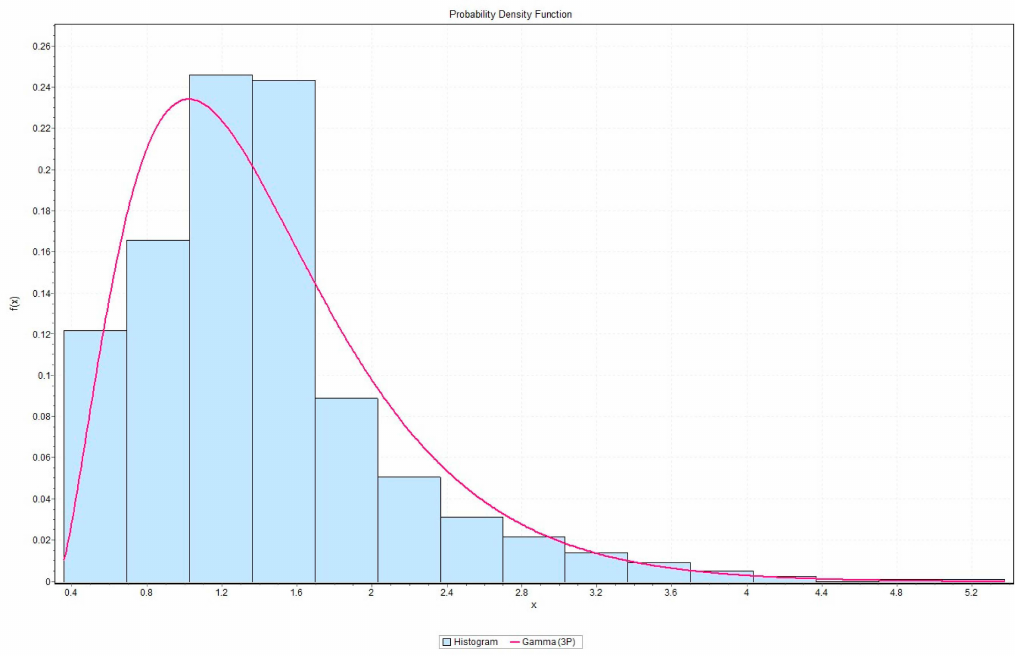
Figure 6. Probability density function for the 3-P gamma distribution during the event of 17/11/2005.